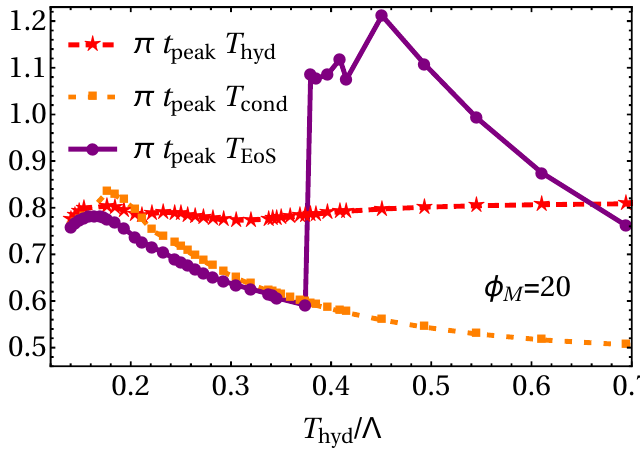
Figure 14 . Comparison of the delay in the peak of the scalar condensate, t peak , and the e(cid:11)ective temperatures at the times of hydrodynamization, scalar relaxation and